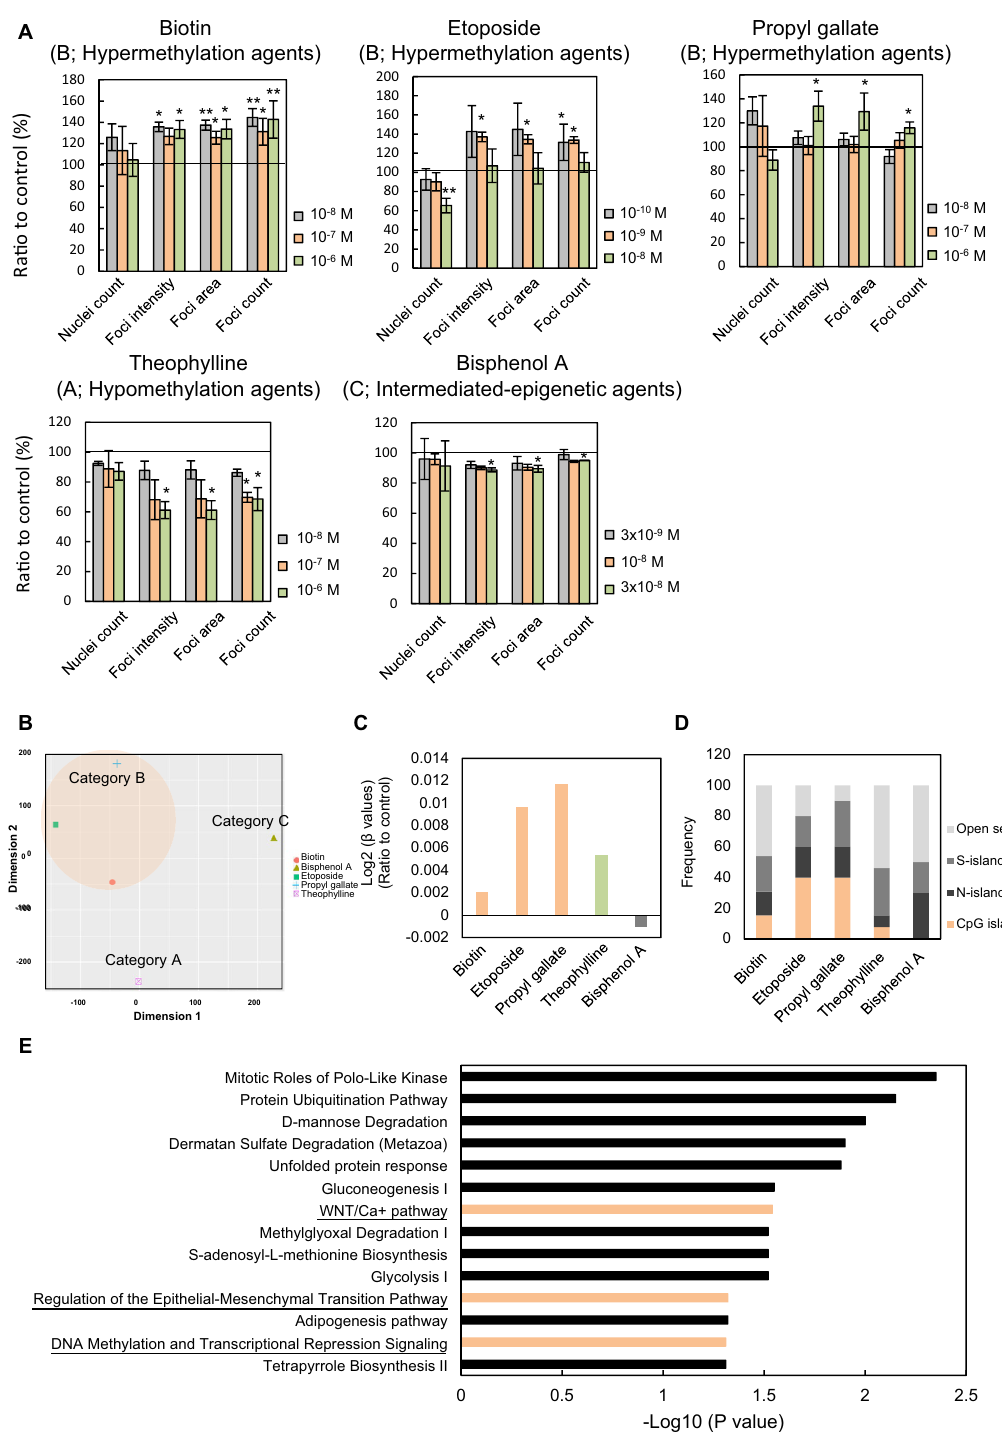
Figure 4. Effect of hypermethylation agents on genome-wide and gene-specific DNA methylation patterns in human iPSCs. ( A ) Concentration-dependent effects on fluorescent MBD parameters of human iPSCs. Cells were treated with 1 × 10 −8 , 1 × 10 −7 , and 1 × 10 −6 M biotin, 1 × 10 −10 , 1 × 10 −9 , and 1 × 10 −8 M etoposide, and 1 × 10 −8 , 1 × 10 −7 , and 1 × 10 −6 M propyl gallate (category B, hypermethylation agents); 1 × 10 −8 , 1 × 10 −7 , and 1 × 10 −6 M theophylline (category A, hypomethylation agent); and 3 × 10 −9 , 1 × 10 −8 , and 3 × 10 −8 M bisphenol A (category C, intermediated epigenetic agent) for 48 h. Graphs showed the ratios of each fluorescent MBD parameter ratio to the vehicle control. Data were expressed as the means of the control ratio ± the standard error of three independent experiments. * P < 0.05; ** P < 0.01 relative to the vehicle control. ( B ) t-SNE analysis of β-values relative to the vehicle control. ( C ) Changes in DNA methylation rates at all sites. Data are presented as the mean of log2 (β-values) ratio to the vehicle control. ( D ) Distributions of the genome area of differential methylated site relative to the vehicle control. ( E ) Top canonical pathways associated with the common hypermethylated genes with a fold change threshold of more than 10 following treatment with etoposide or propyl gallate using Ingenuity Pathway Analysis. − Log10 ( P values) of statistically significant pathways ( P < 0.05) are presented. See also Table